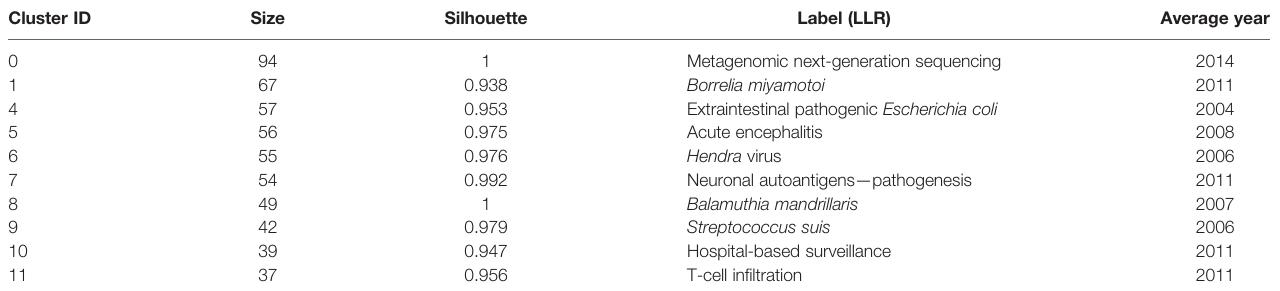
TABLE 1 | Summary of the largest 10 clusters.